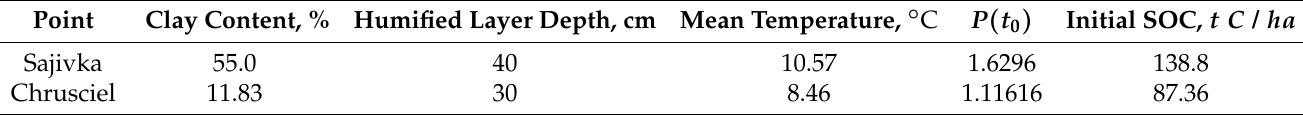
Figure 4. Locations of points with SOC data in Poland and Ukraine. Table 5. Summary of the datasets from